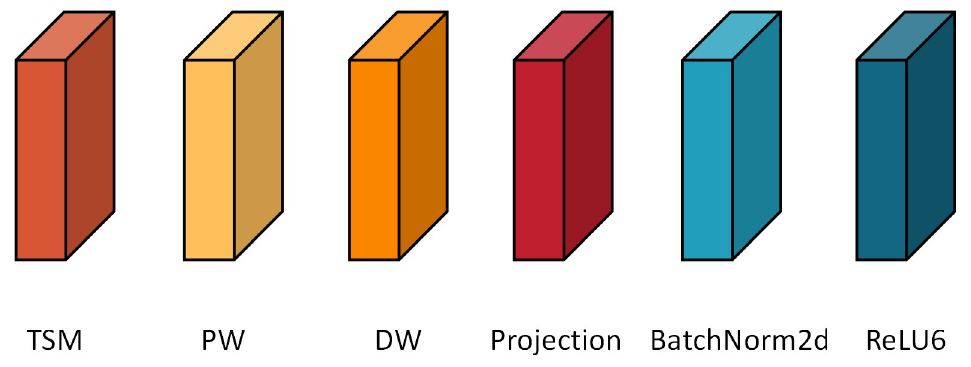
Fig 3. Diagram of basic